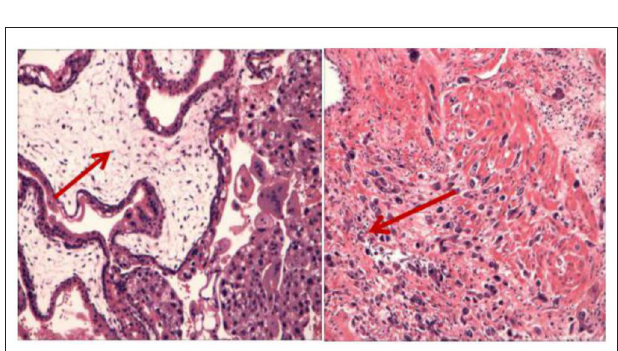
FIGURE 3 | The histopathological examination showed obvious proliferation of trophoblasts and enlarged villi with the formation of a central pool, which invaded the entire posterior wall of the uterus. Coincidence the aggressive